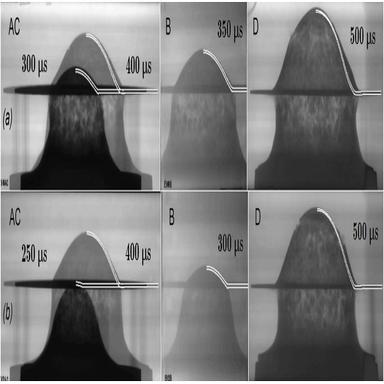
Experimental flash X-ray results and comparison with the calculations (shown as half plate white contours) for the as-received calcite sand, ρ0 = 1.31 g/cm3 (a) and pre-compacted sand, ρ0 = 1.49 g/cm3 (b) loaded by the configuration U charge.